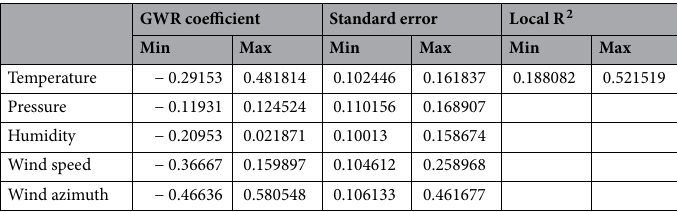
Table 6. Summary statistics for GWR on the 11th of March.